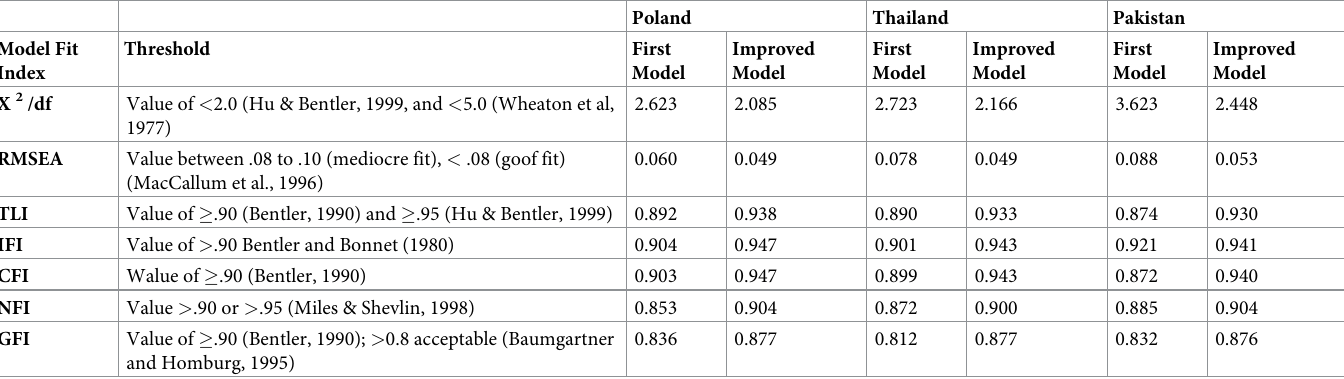
Table 3. Model fitness evaluation statistics.